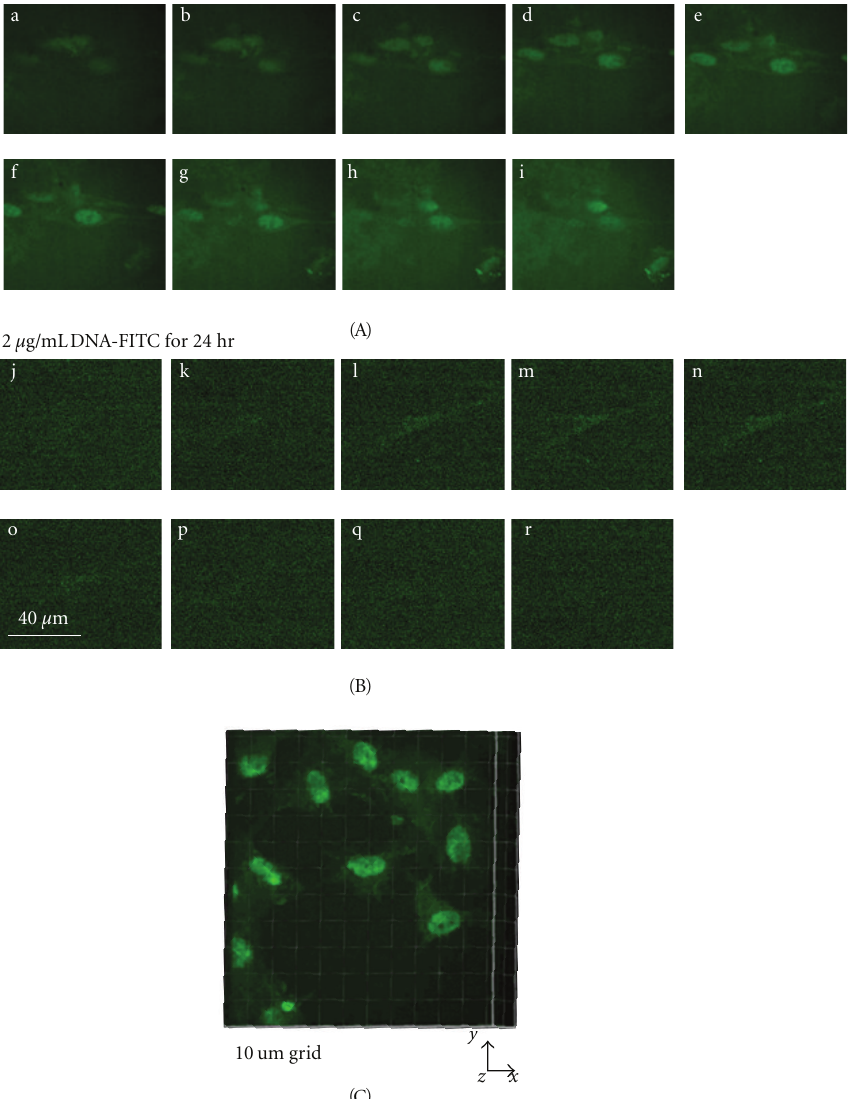
Figure 1: A series of z-stack images demonstrating di ff erential distribution of SWCNT-DNA-FITC (2 µ g/mL) versus DNA-FITC (2 µ g/mL) conjugates in microvascular ECs: (A) (a to i), representative optical section series of SWCNT-DNA-FITC conjugates in microvascular ECs at 24 hrs post incubation; (B) (j to r), representative optical section series of DNA-FITC present in microvascular ECs at 24hrs post incubation; (C), sample 3-D image from a video (supplemental materials) acquired from ECs by a spinning confocal imaging system